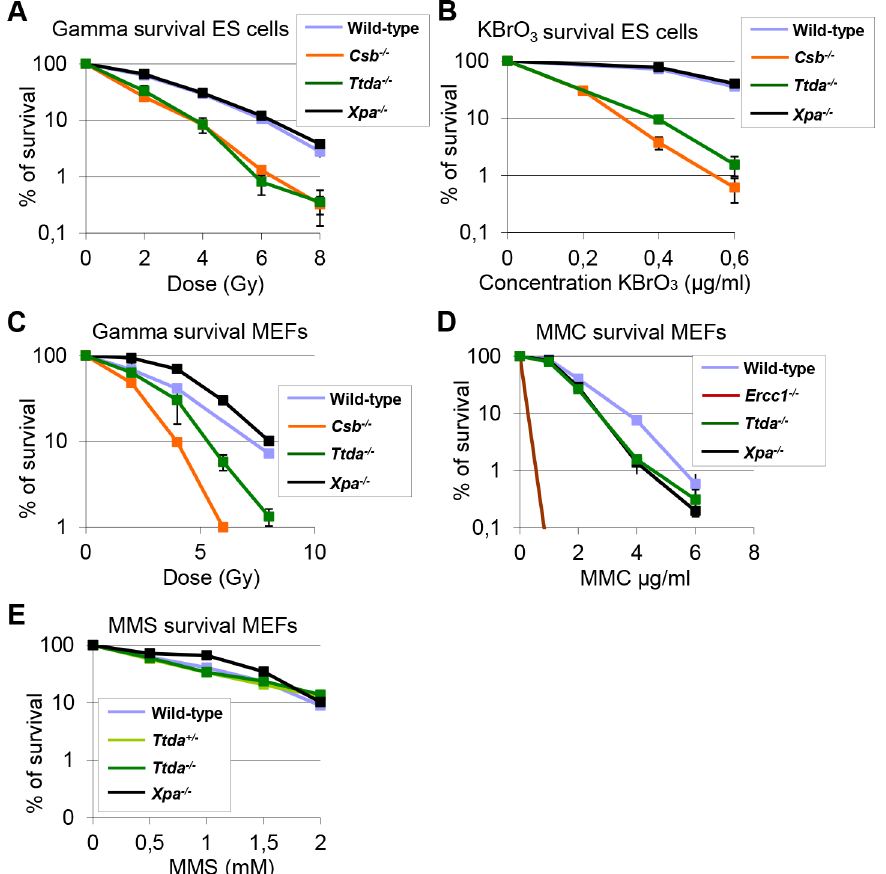
Figure 7. Ttda 2 / 2 ES cells and MEFs exhibit oxidative DNA damage sensitivity. (A) Colony forming ability after different doses of gamma irradiation of wild-type, Ttda 2 / 2 , Csb 2 / 2 and Xpa 2 / 2 ES cells. The percentage of surviving cells was plotted against the applied gamma-dose. (B) Colony forming ability after different concentrations of KBrO 3 of wild-type, Ttda 2 / 2 , Csb 2 / 2 and Xpa 2 / 2 ES cells. The percentage of surviving cells was plotted against the applied gamma-dose. (C) Colony forming ability after different doses of gamma irradiation of wild-type, Ttda 2 / 2 , Csb 2 / 2 and Xpa 2 / 2 MEFs. The percentage of surviving cells was plotted against the applied gamma-dose. (D) Colony forming ability after different doses of 1 hour MMC treatment of wild-type, Ttda + / 2 , Ercc1 2 / 2 and Xpa 2 / 2 MEFs. The percentage of surviving cells was plotted against the applied gamma- dose. (E) Colony forming ability after different doses of 1 hour MMS treatment of wild-type, Ttda + / 2 , Ttda 2 / 2 and Xpa 2 / 2 MEFs. The percentage of surviving cells was plotted against the applied gamma-dose. For each survival plot (A–E) at least 2 different clones per genotype were measured in two independent experiments. The error bars indicate the SEM.